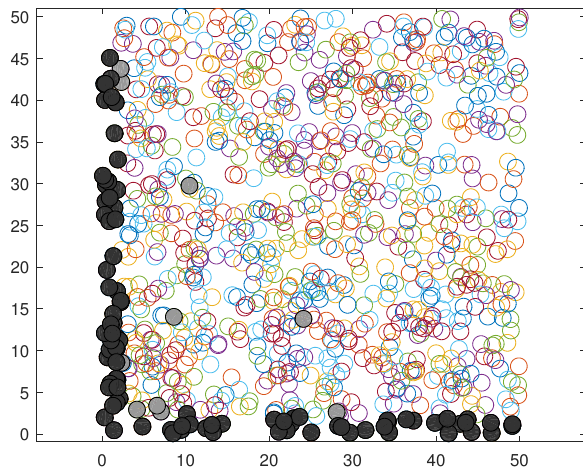
Figure 3. The randomly generated family of sets from Example 2 with H = { ( 0,0 ) T } , i.e., we do not consider approximate minimal elements here, but look for the minimal elements of the family of sets A . The lightly and darkly filled circles belong to the set T generated by Algorithm 2, while the minimal elements of the set A are the darkly filled